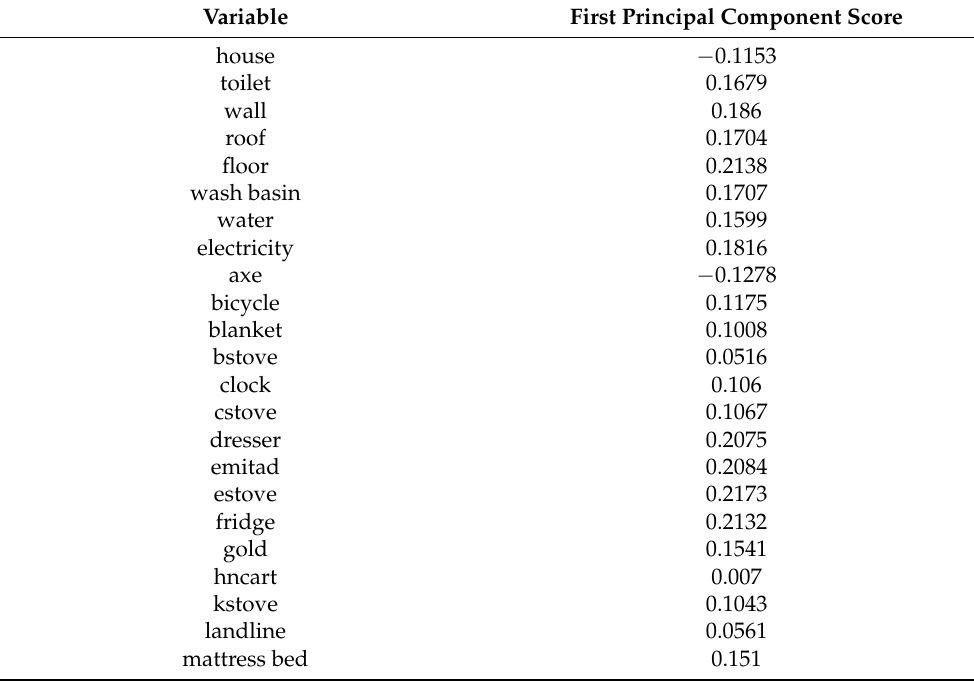
Table A4. Asset index for Ethiopia—Results from Tetrachoric Principal Components